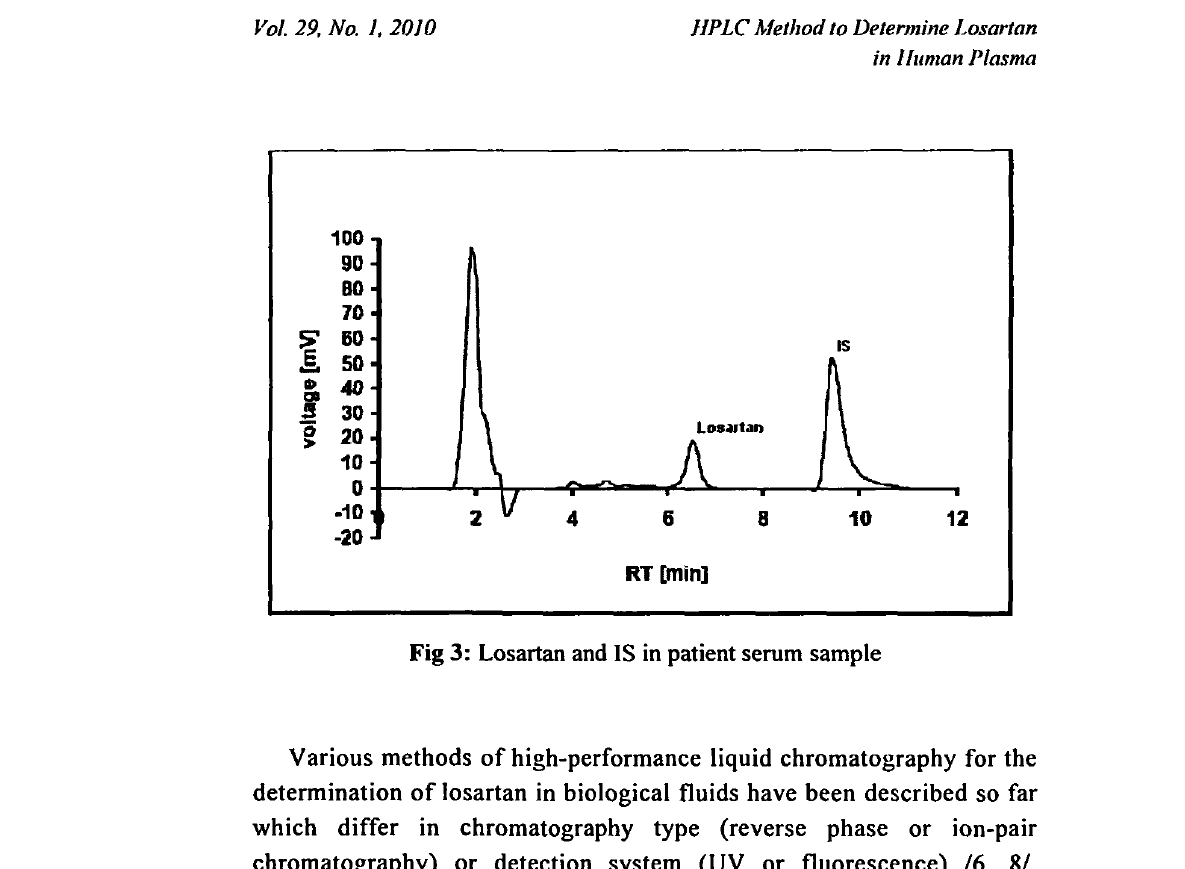
Fig 3: Losartan and IS in patient serum